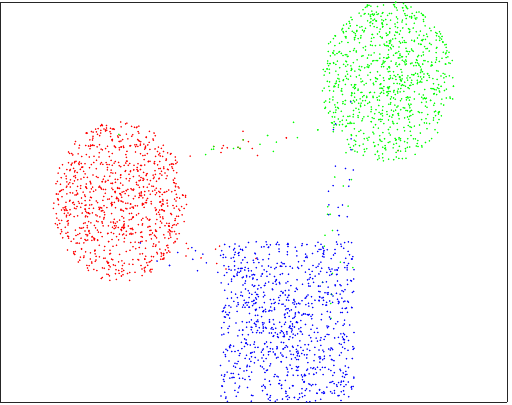
Fig. 6 KNN imputation result ( K DDD 3).